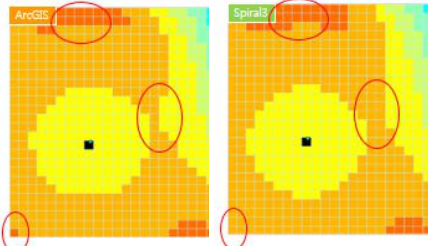
Figure 6. Quadratic Comparison: ArcGIS (left), Spiral 3 (right)